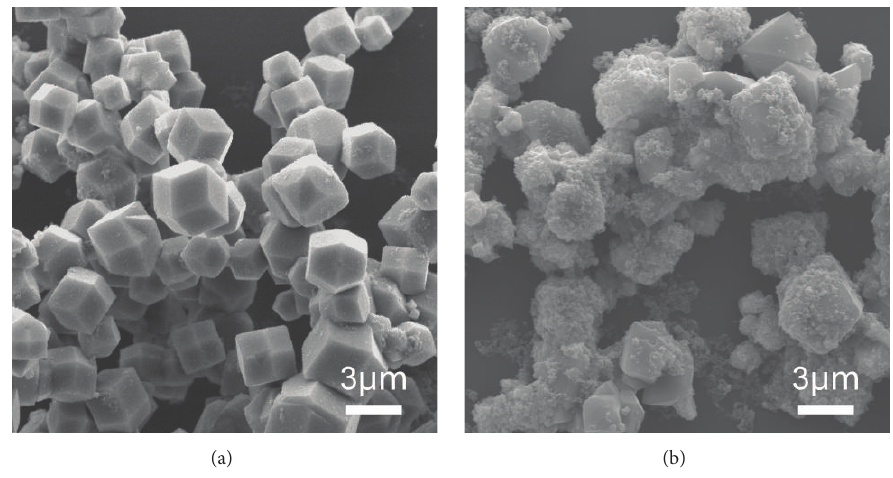
Figure 5: SEM images of samples with different Fe 3+ concentration at pH = 9, (a) [Fe 3+ ] = 0.5 mmol, (b) [Fe 3+ ] = 2.5